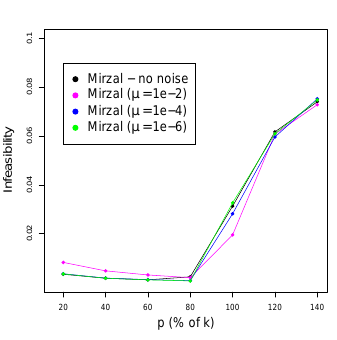
Values of infeas G , H achieved by Algorithm 1 for n = 200, on the original and on the noisy BION data.